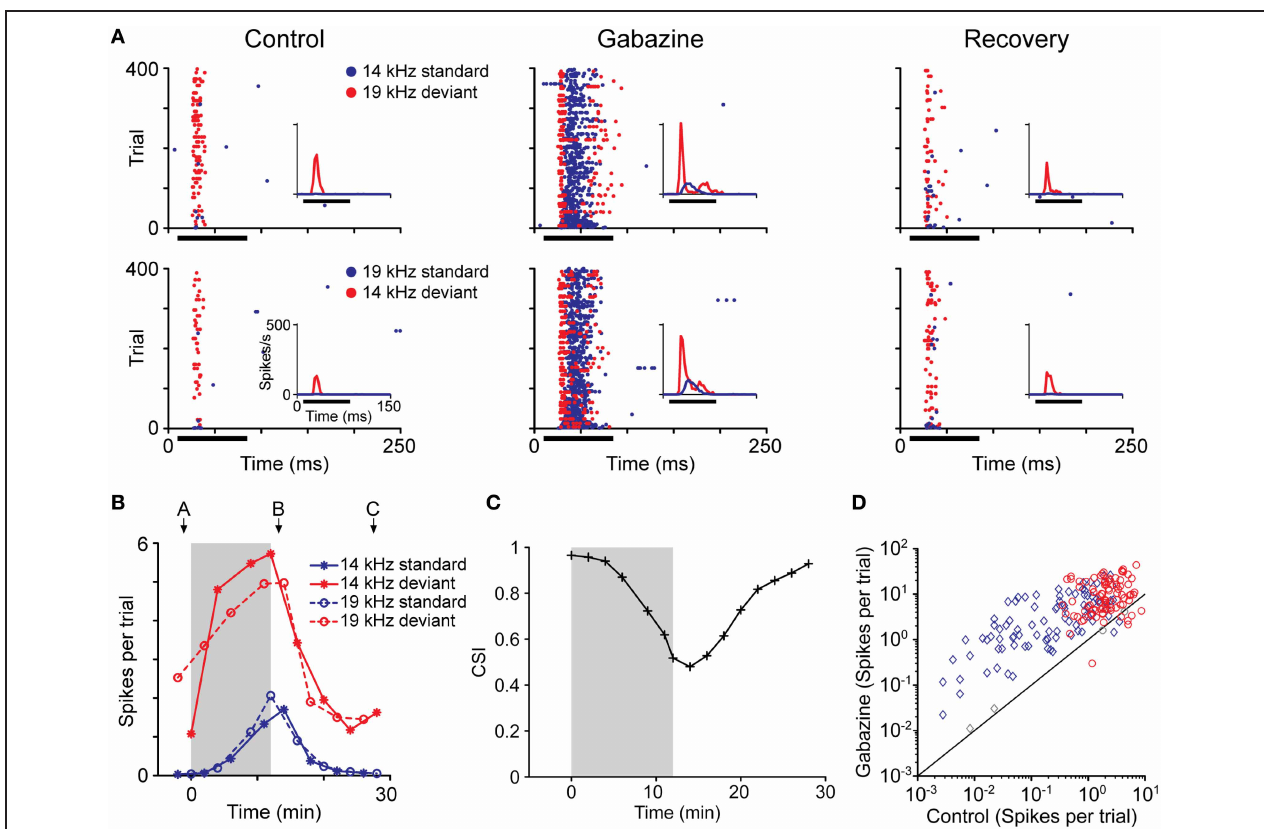
FIGURE 10 | Effect of the blockade of GABA A receptors on the response magnitude for deviant and for standard stimuli. (A) Dot rasters showing the effect of gabazine blockade of GABA A receptors on the responses of a neuron with SSA. The frequencies tested in the oddball paradigm were 14kHz and 19kHz ( (cid:2) f = 0 . 3, 0.43 octaves). The insets show a PSTH of the response (3ms bin size); the horizontal black bar indicates the duration of the stimulus. Before the application of gabazine, this neuron responded much more strongly to both frequencies when they were presented as the deviant than when they were presented as the standard stimulus, resulting in a CSI of 0.965. The application of gabazine for 12min increased the response to both types of stimuli, but the relative increment was larger for the standards, causing the CSI to drop to 0.480. Fifteen minutes after the end of gabazine application, the neuron’s response recovered to the control level, and the CSI increased to 0.926. (B) Evolution of the response magnitude of the neuron (mean spikes per trial) shown in (A) in response to standards (blue lines) and